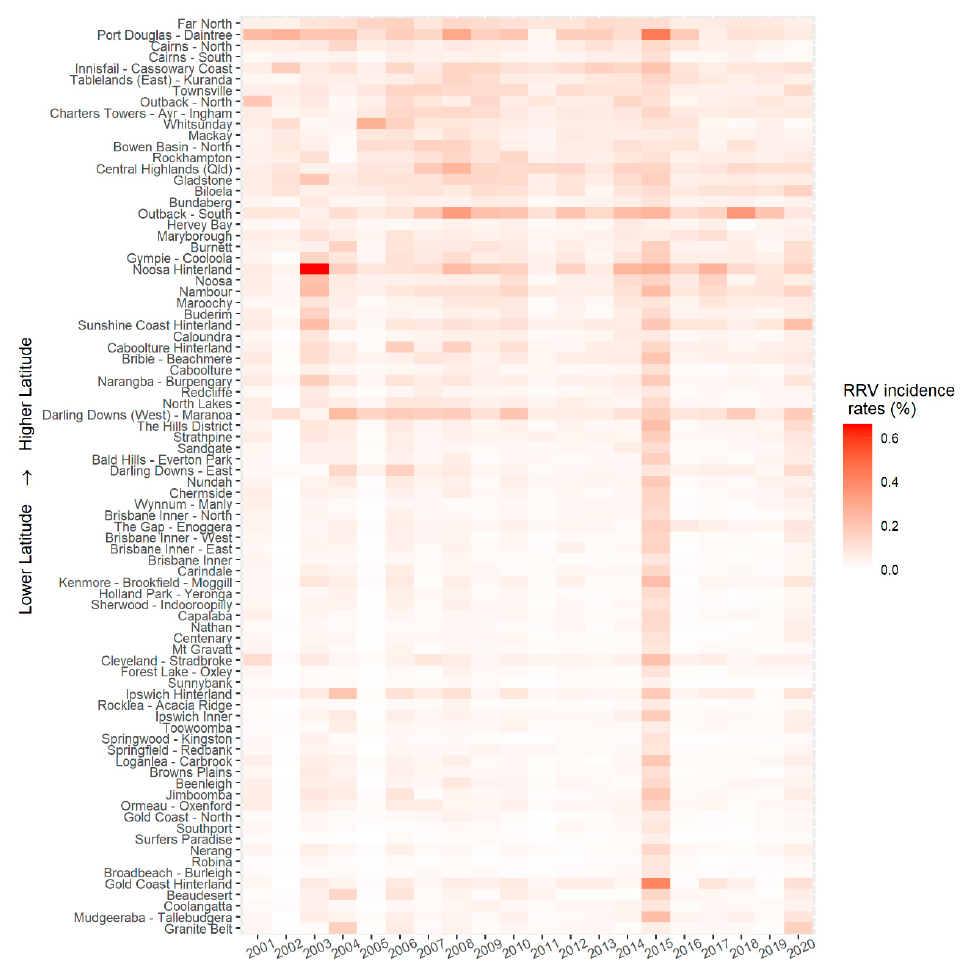
Figure 4. Yearly Ross River virus incidence rates in SA3 areas of Queensland from 2001–2020 (ordered by latitude).